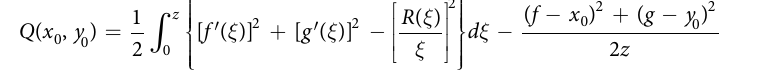
52 , showing a vortex field with TC of